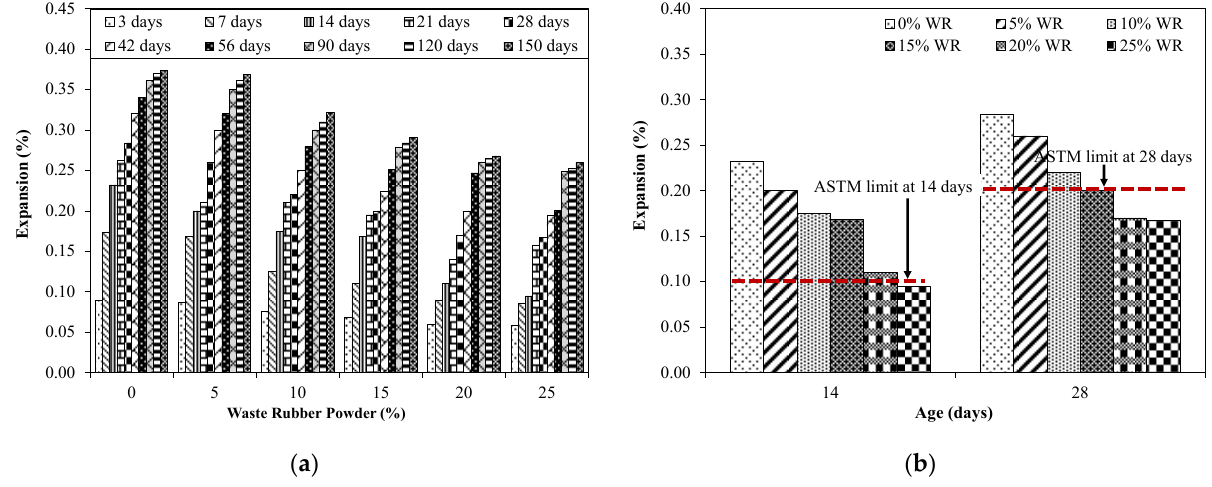
Figure 14. Effect of RW on expansion results and ASTM C1260 limits. ( a ) Expansion results; ( b ) ASTM limits for expansion.